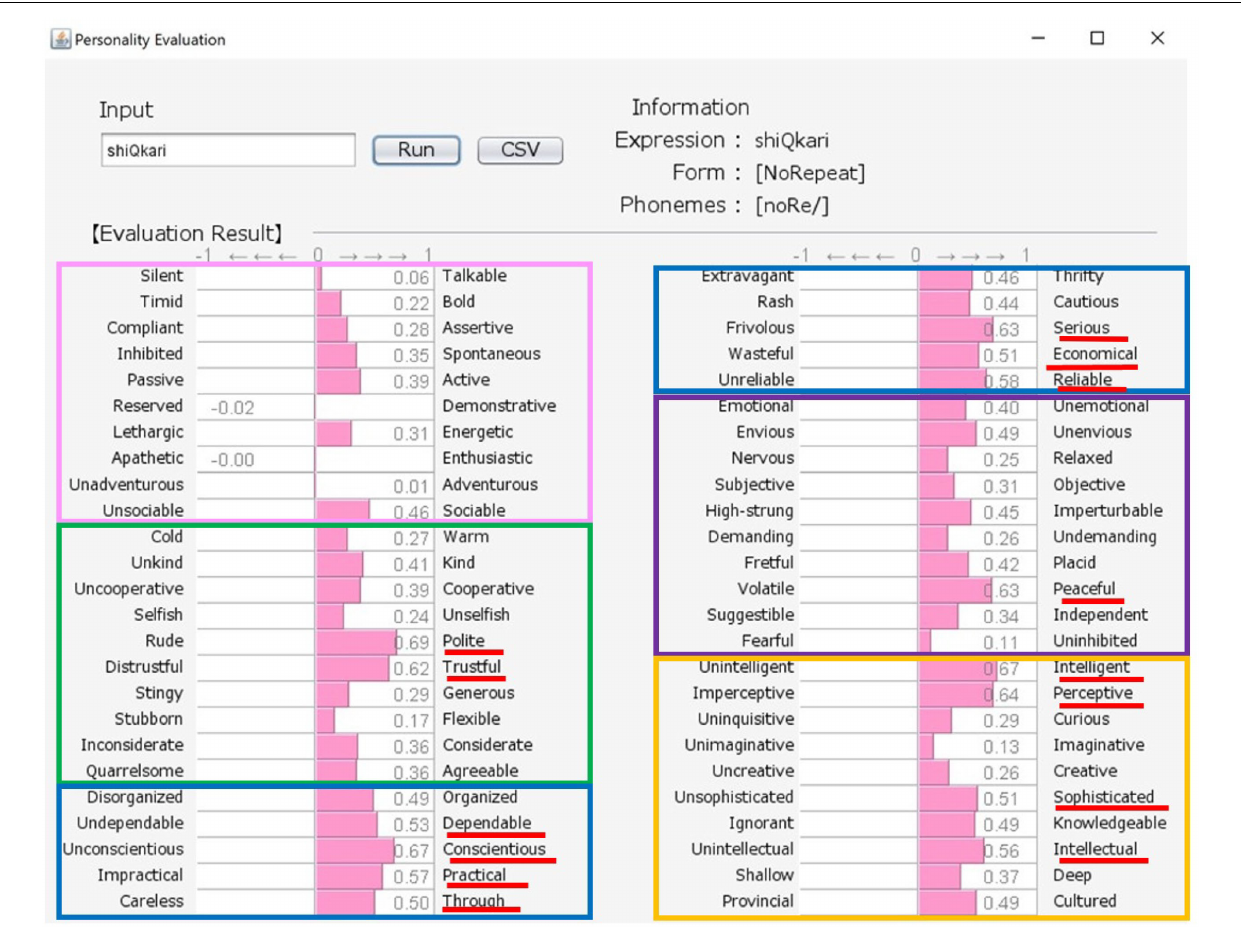
FIGURE 6 | Output for “shikkari (solid)” personality. The pink, green, blue, purple, and orange frames indicate Extroversion, Agreeableness, Conscientiousness, Neuroticism, and Openness, respectively.